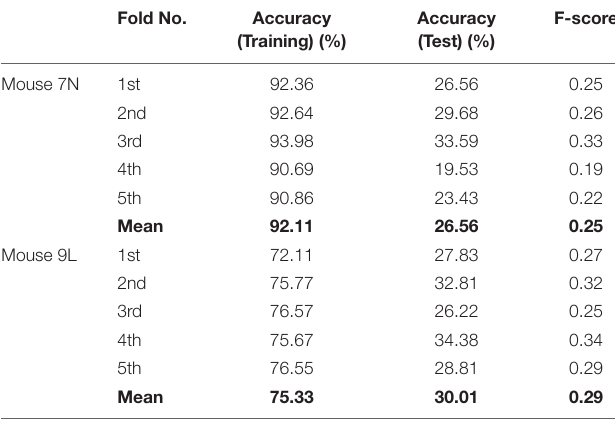
Bold values indicate data group names, performance matrices and mean results of five-fold cross